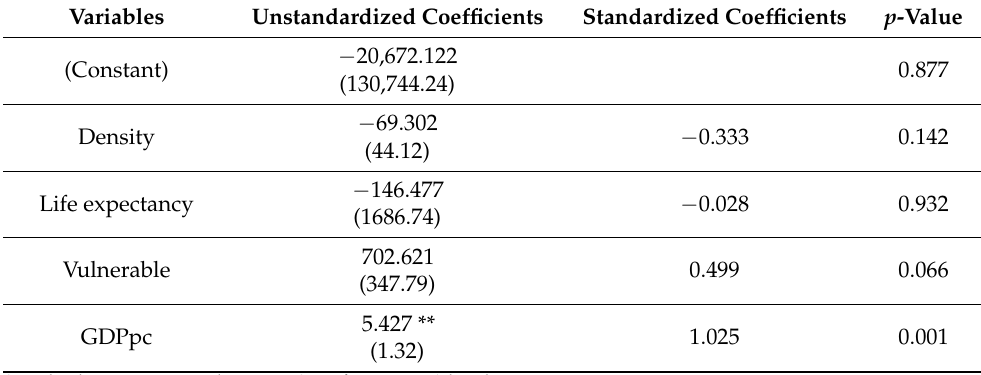
Table 4. Multiple regression model on confirmed cases of COVID-19 per million